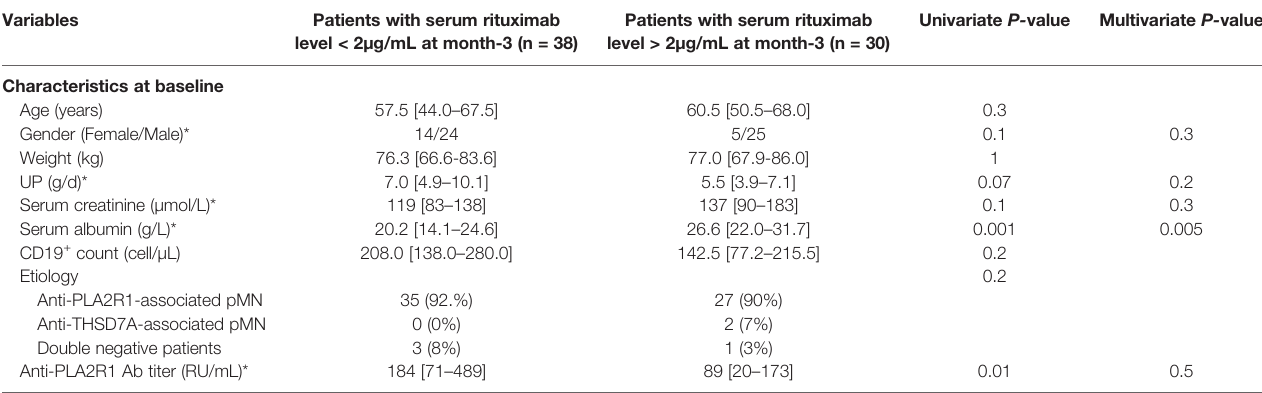
TABLE 4 | Univariate and multivariate analysis of variables associated with serum rituximab levels at month-3.